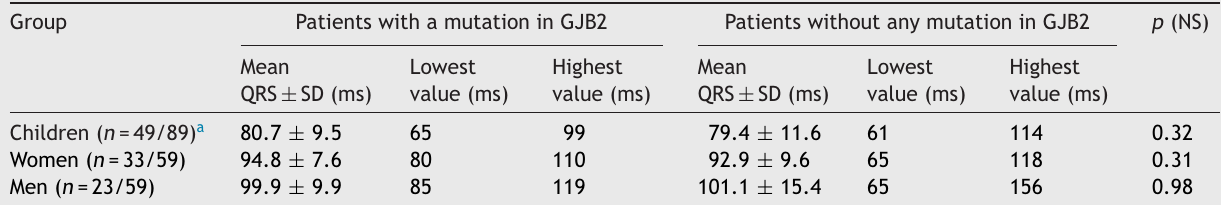
Findings of QRS complex in the ECG study population. Group